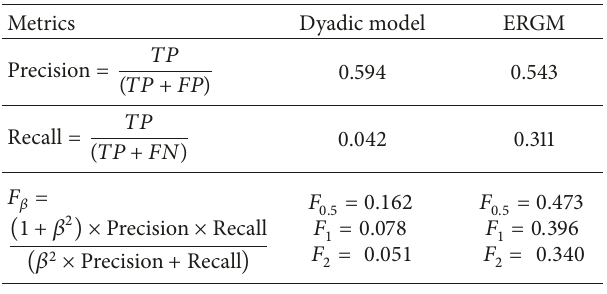
Table 6: Results of various metrics for link-level comparison (predicted links based on threshold at 0.5).